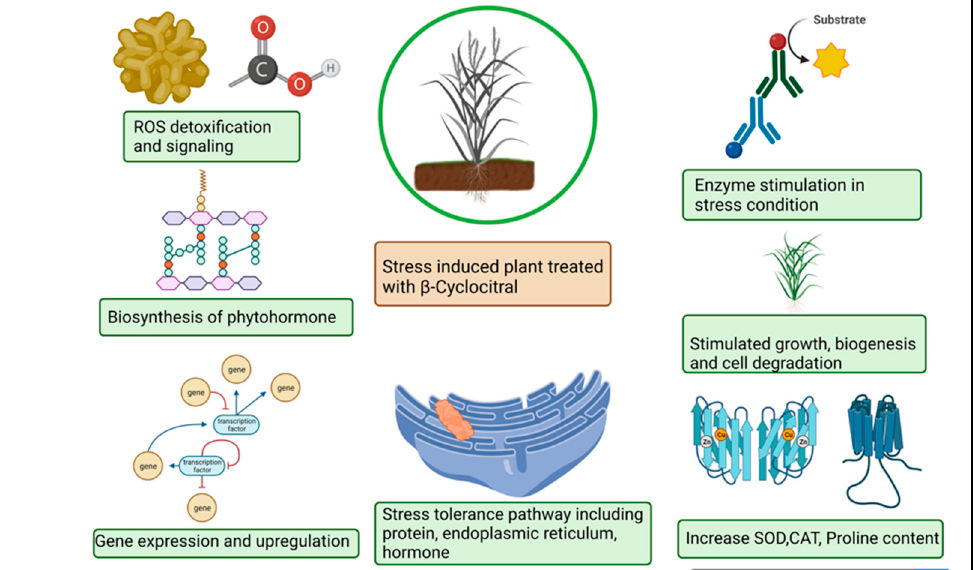
Figure 3. Schematic representation of β -cyclocitral effects on plants under abiotic stress.